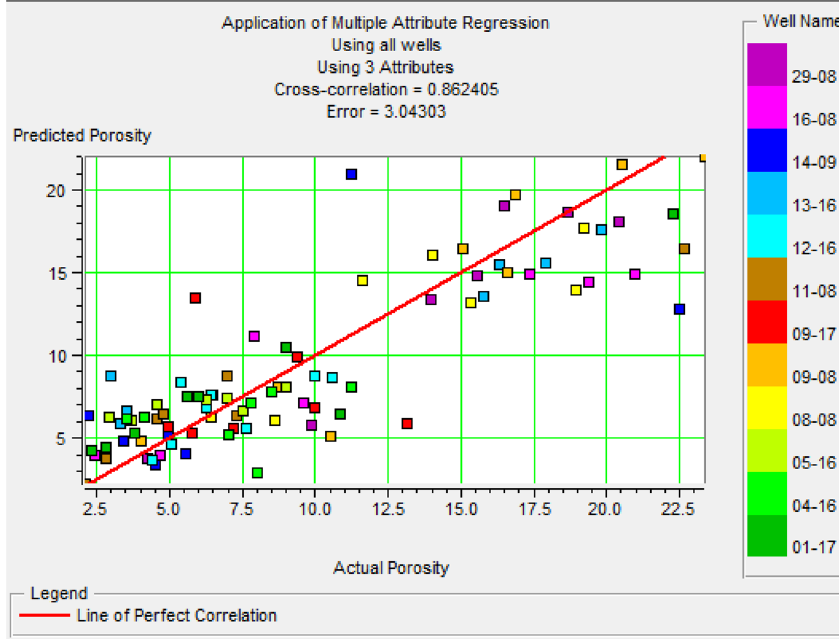
Fig. 19 Diagram of estimated porosity versus actual porosity for the data third category by using multi-attribute